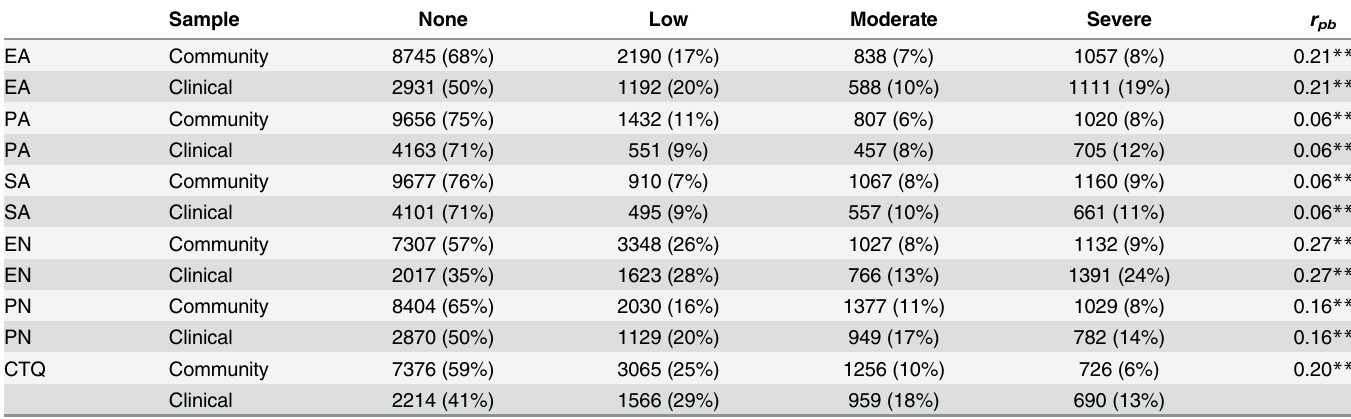
Table 2. Associations between CTQ Total and Subscale Score Severity Ratings and Community (n = 12432 – 12915) * versus Clinical (n = 5429 – 5876) *